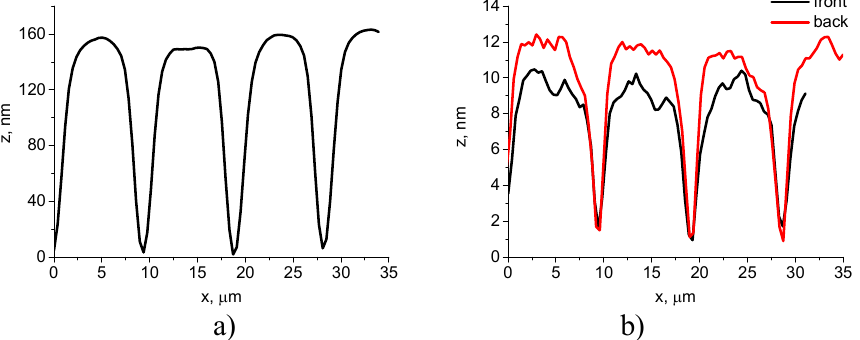
Fig. 5. Profiles of the created diffraction gratings showing PMMA shrinkage: a) PMMA film on glass; b) free-standing PMMA